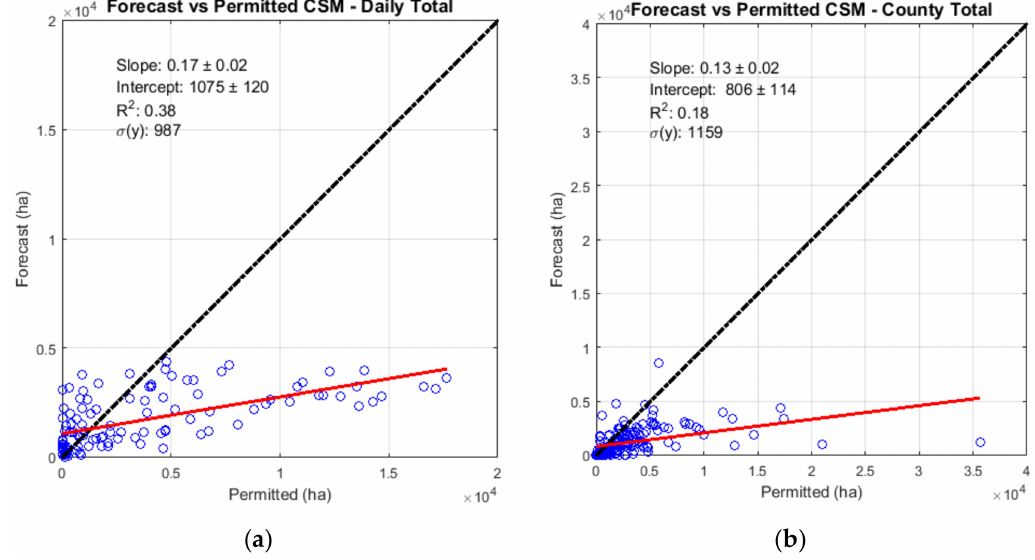
Figure 6. Forecast from county-specific models versus permitted ( a ) daily total burn areas in Georgia; and ( b ) county total burn areas for the January–April 2016